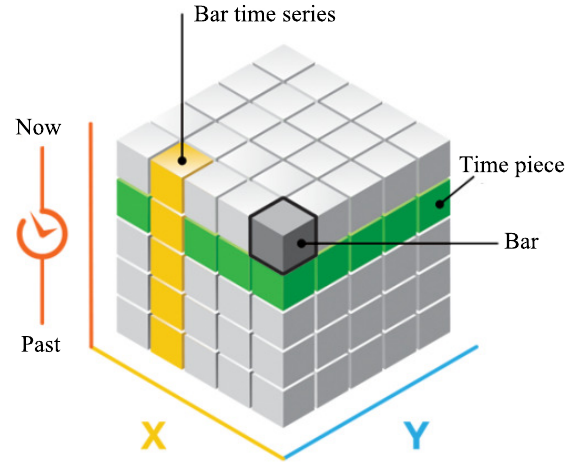
Figure 2. Schematic diagram of the space-time